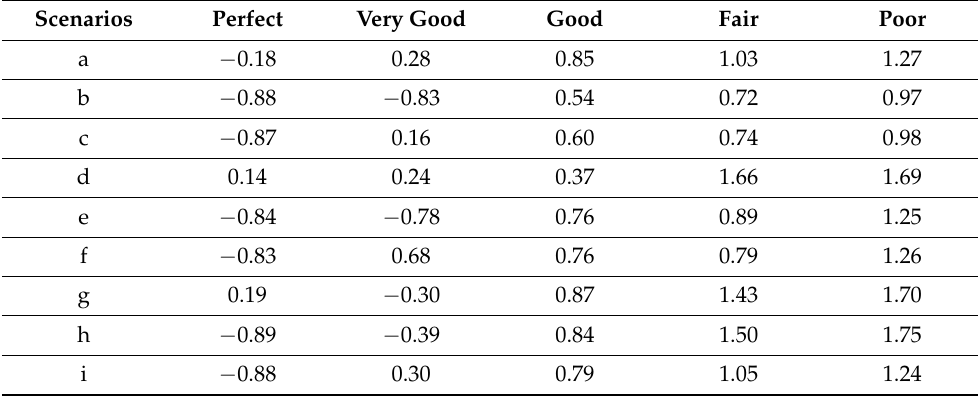
Table 9. The correlation degree between the calculated results of different scenarios.